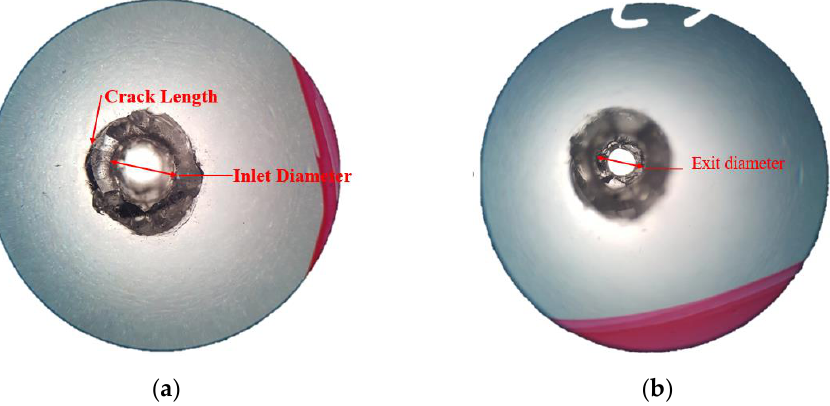
Figure 2. Microscopic images of drilled holes and measured parameters: ( a ) CL = 0.287 mm and D INLET = 0.971 mm obtained at 0.075 wt.% CNPs, T E = 0.5 s, P = 20 W and N P = 6 pulses, and ( b ) D EXIT = 0.247 mm obtained at 0.1 wt.% CNPs, T E = 0.5 s, P = 20 W and N P = 3 pulses.